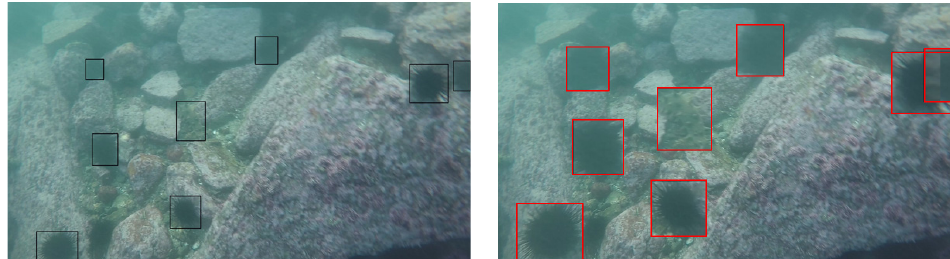
Figure 4. A randomly expanded image example of small targets. The black boxes represent the targets before expansion, and the red boxes represent the targets after expansion.